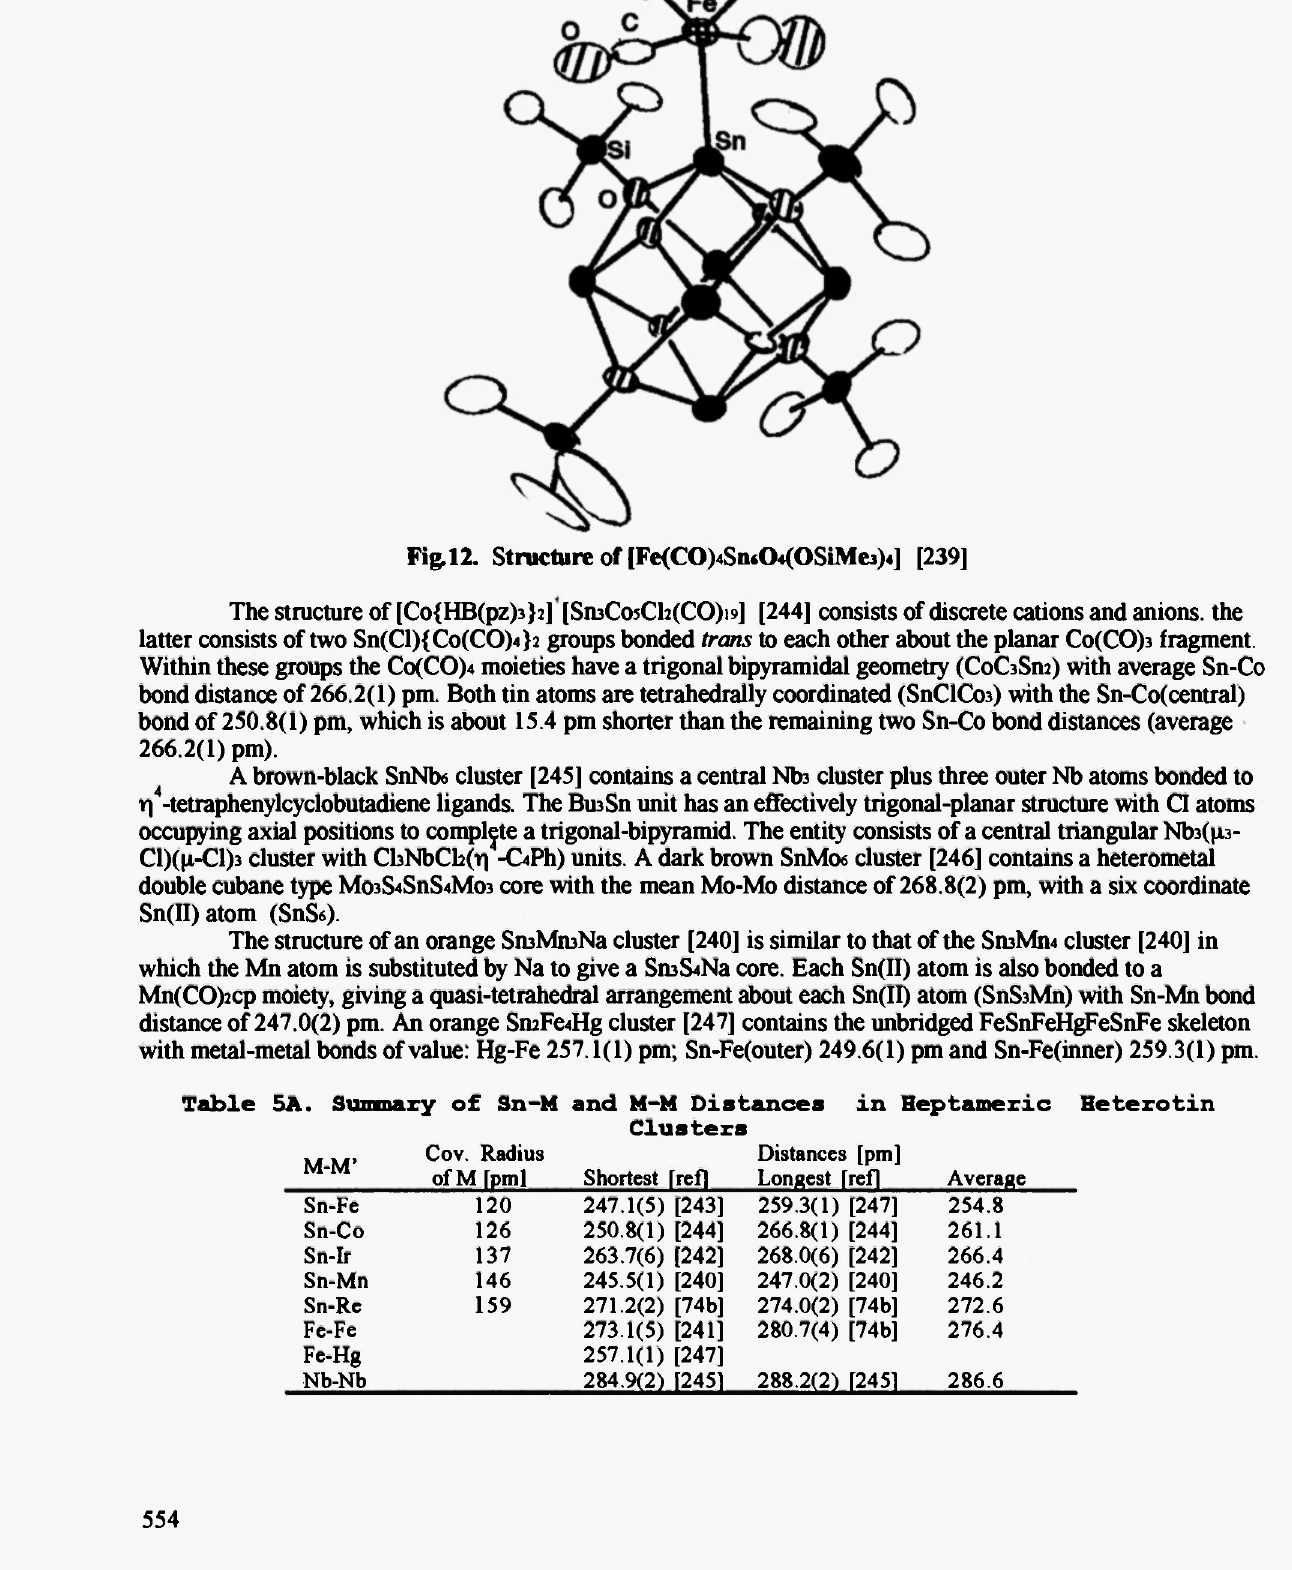
Table 5A. Sumnary of Sn-M and M-M